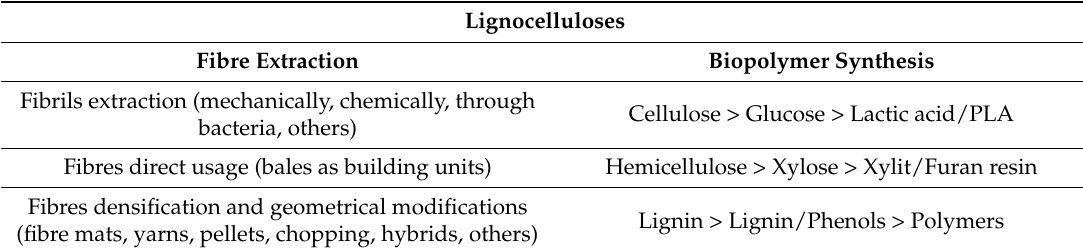
Table 1. Illustration of the fibres and polymers’ extraction possibilities from the lignocellulosic fibre component ([8,9]). PLA: poly lactic